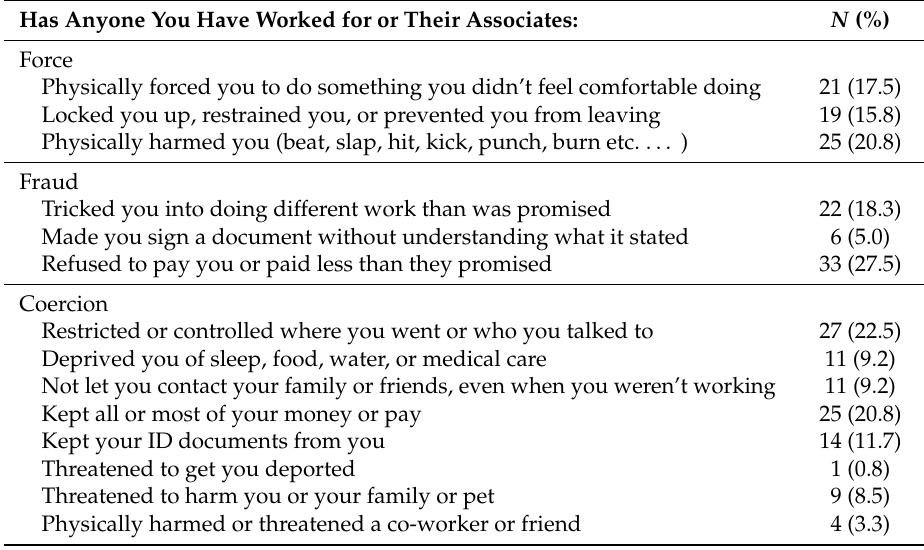
Table 3. Work-related exploitation identified using the Human Trafficking Screening Tool ( N =